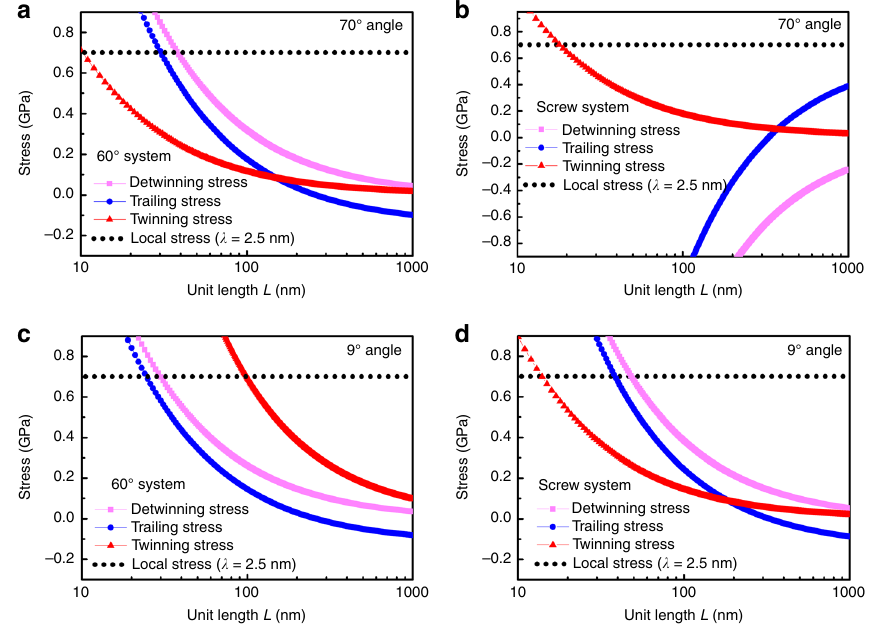
Fig. 6 Distribution of twinning and detwinning stresses during tensile deformation. 70° ( a , b ) and 9° ( c , d ) angles of the fi rst TB to the tensile direction. a , c 60° system. b , d Screw system. The activation of twinning requires the twinning stress lower than both the local stress and trailing stress, thus, twinning is prohibited at L > 180 nm in a . When the detwinning stress is smaller than the local stress, detwinning occurs. Therefore, detwinning is dominant in a ( L > 40 nm). On the opposite, twinning in b is the featured deformation behavior due to the negative trailing and detwinning stresses in the screw system. Detwinning controls the deformation in c ( L > 40 nm) and d ( L > 60 nm), whereas twinning occurs in d in a smaller range ( L < 180